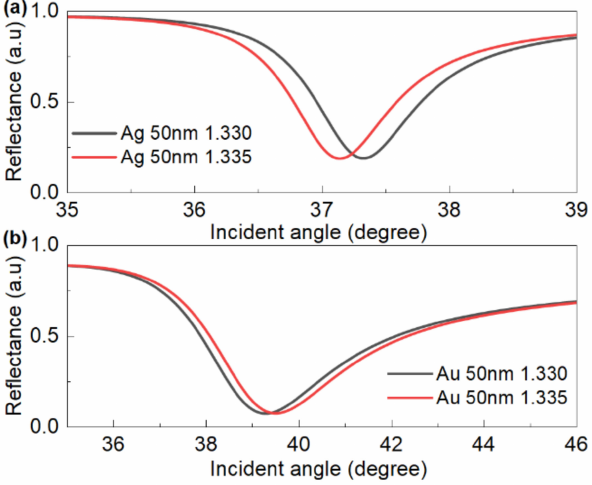
Figure 7. Reflectance spectra of the SPR sensor with ( a ) single-layer Ag film and ( b ) single-layer Au film.